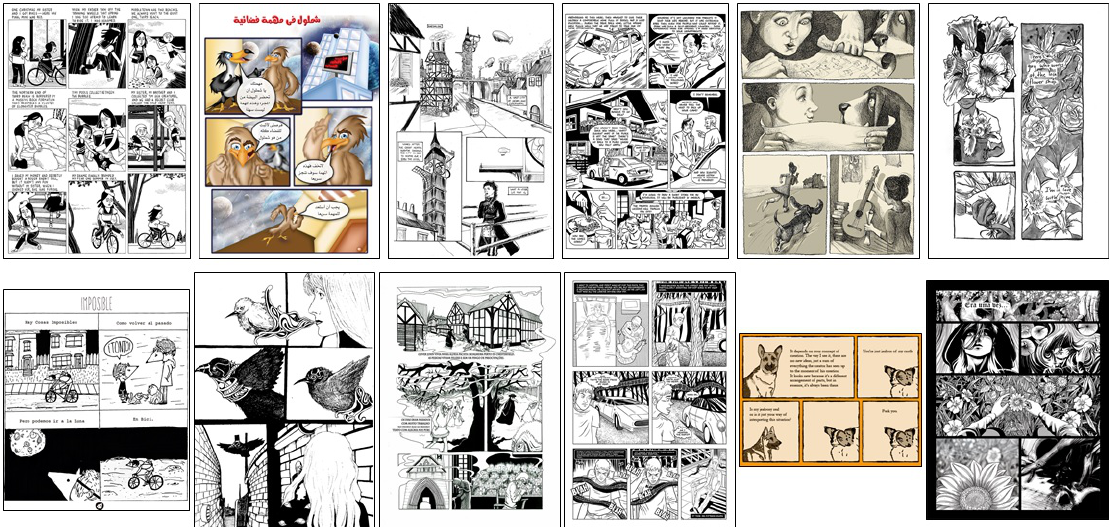
Figure 13. Example of comics contained in the BAM! dataset [11]. From left to right we selected two images containing the following labels: bicycles, birds, buildings, cars, dogs, and